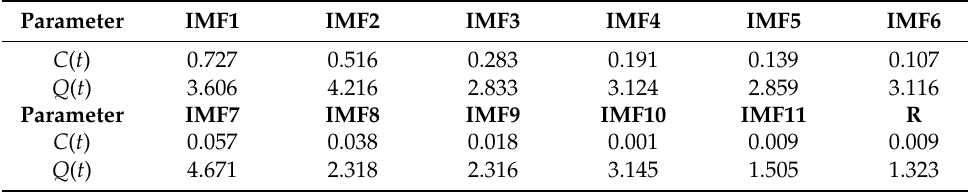
Table 3. Index values of different IMF signal components